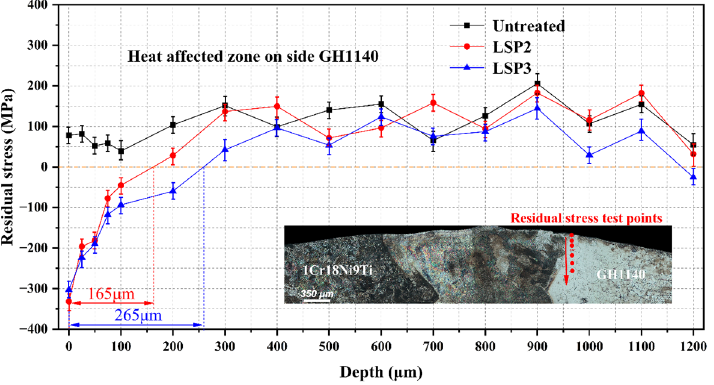
Figure 5. Depth residual stress distribution in HAZ on side GH1140 of combustion liner weld.